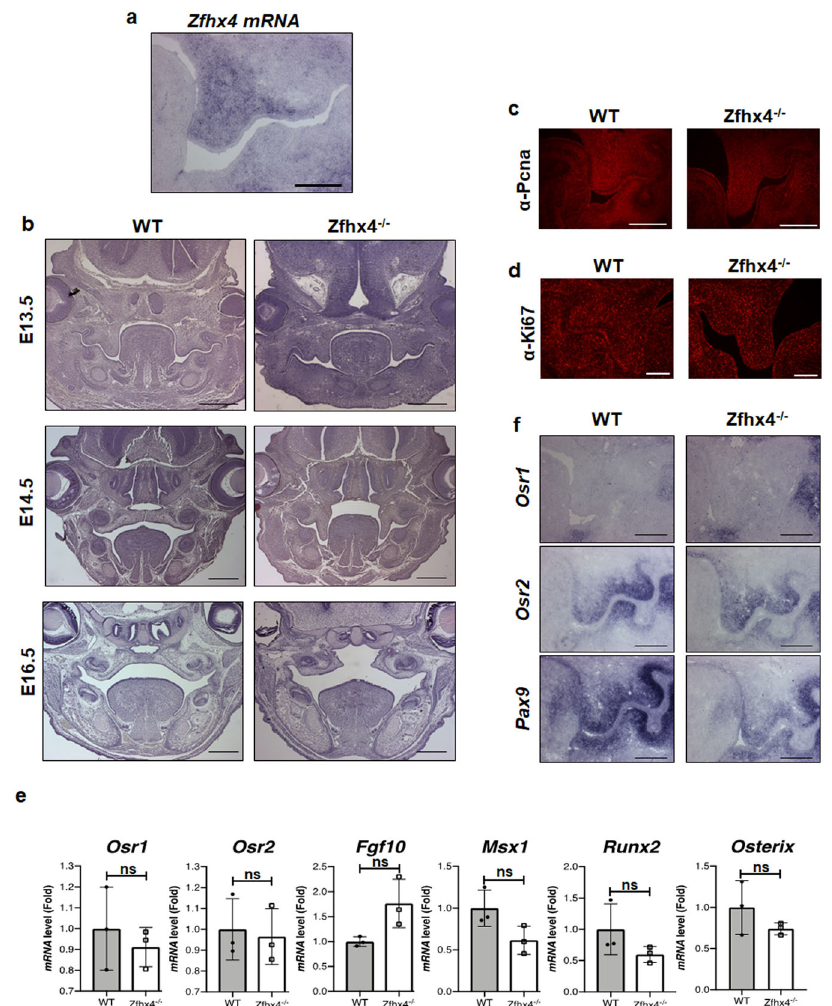
Fig. 4 Critical role of Zfhx4 in palate development. a Zfhx4 expression in the palatal shelf of E13.5 mice determined by in situ hybridization. Scale bar = 200 μ m. b Coronal sections of crania of E13.5, E14.5, and E16.5 wild-type (WT) and Zfhx4 − / − littermates stained with hematoxylin and eosin (HE). Scale bar = 500 μ m. c Fluorescence microscopy images of coronal sections of crania of E13.5 WT and Zfhx4 − / − littermates subjected to immuno fl uorescence analysis using an anti-Pcna antibody. Scale bar = 100 μ m. d Coronal sections of crania of E13.5 WT and Zfhx4 − / − littermates subjected to immuno fl uorescence analysis using an anti-Ki67 antibody. Scale bar = 100 μ m. e Expression levels of genes associated with palatal development in the palatal shelves of E13 WT and Zfhx4 − / − littermates as determined by RT-qPCR using TaqMan probes. Data represent the mean ± s.d. (WT: n = 3; KO: n = 3). f Coronal sections of crania of E13.5 WT and Zfhx4 − / − littermates were examined by in situ hybridization using anti-sense probes against Osr1 , Osr2 , and Pax9 . Scale bar = 200 μ